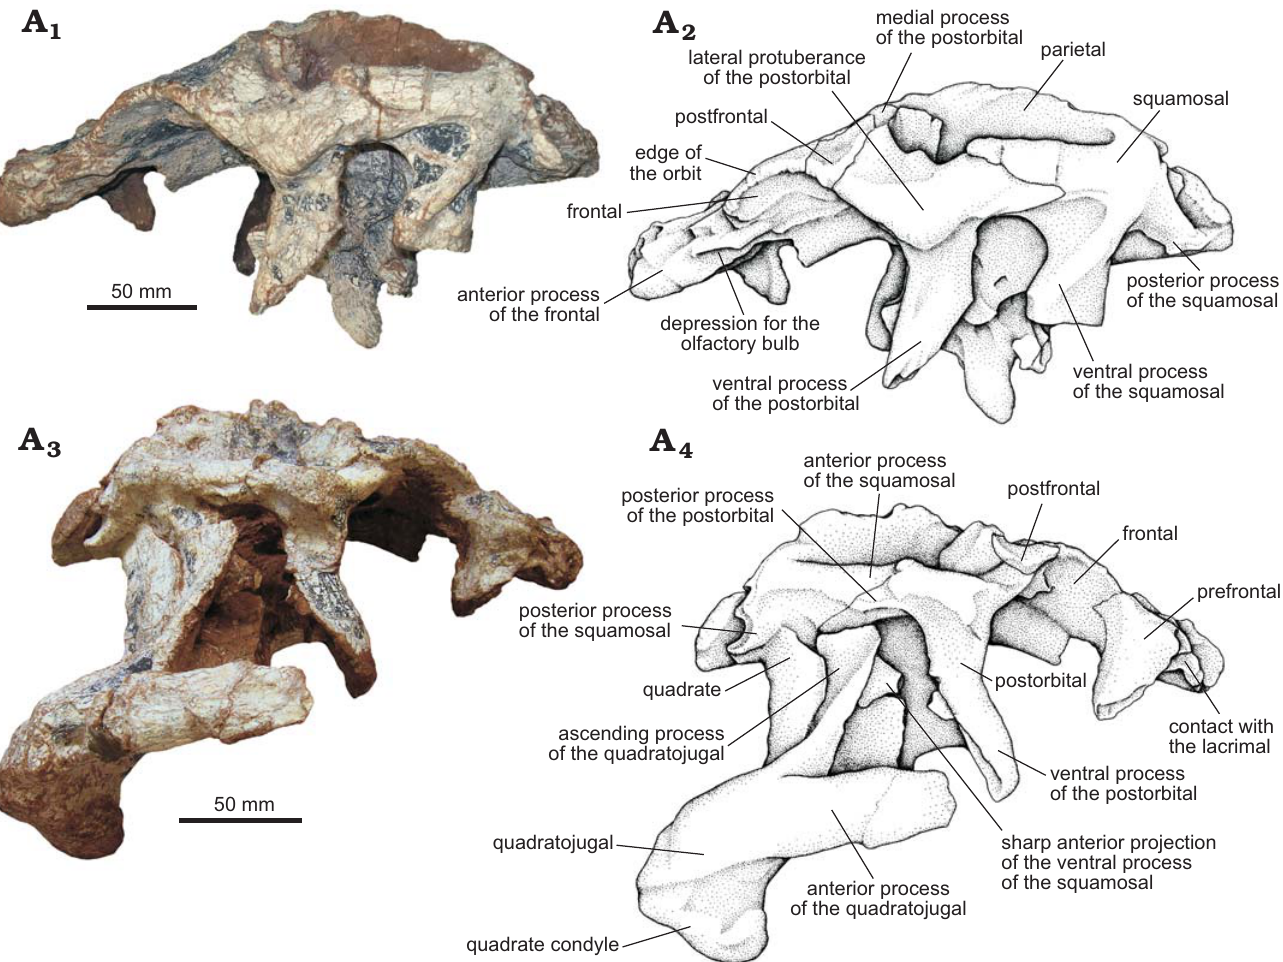
Fig. 10. The pseudosuchian archosaur Prestosuchus chiniquensis Huene, 1938 (UFRGS-PV-0629-T) from the Dinodontosaurus Assemblage Zone, Ladinian, Middle Triassic, Dona Francisca municipality, Rio Grande do Sul State, Brazil; posterior portion of the skull in left (A 1 , A 2 ) and right (A 3 , A 4 ) side views. Photographs (A 1 , A 3 ) and explanatory drawings (A 2 , A 4